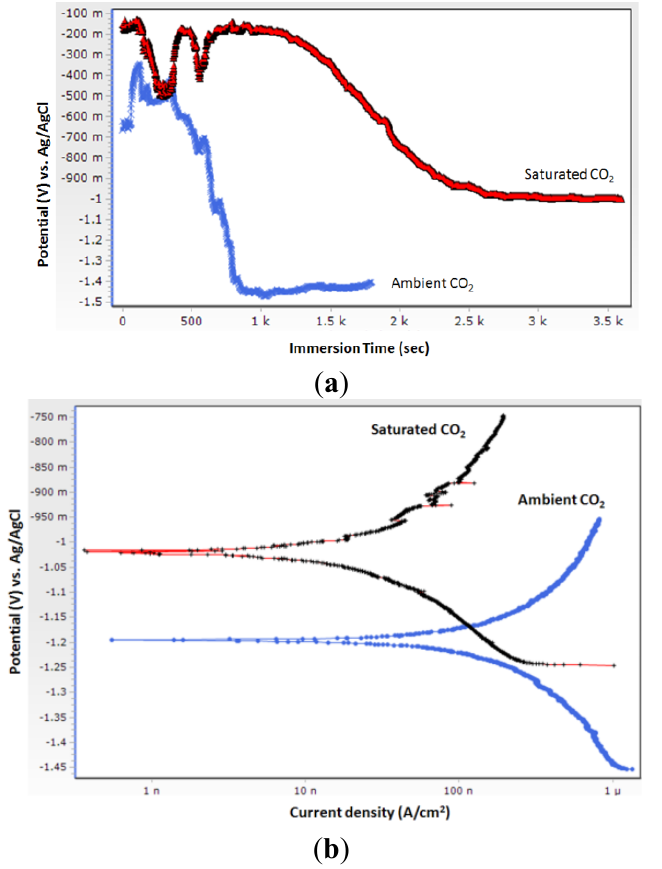
Figure 6. Potentiodynamic polarization curves ( a ) and OCP ( b ) of MgPUnt